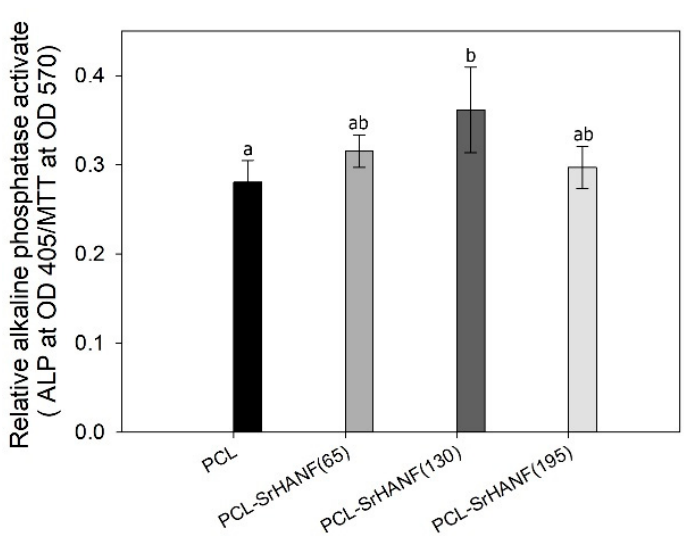
Figure 7. Relative alkaline phosphatase (ALP) activity of MG63 osteoblast-like cells on PCL–SrHANF membranes after 7 days of incubation. The data are presented as the mean ± SD, n = 3. Different letters represent significance at p < 0.05.